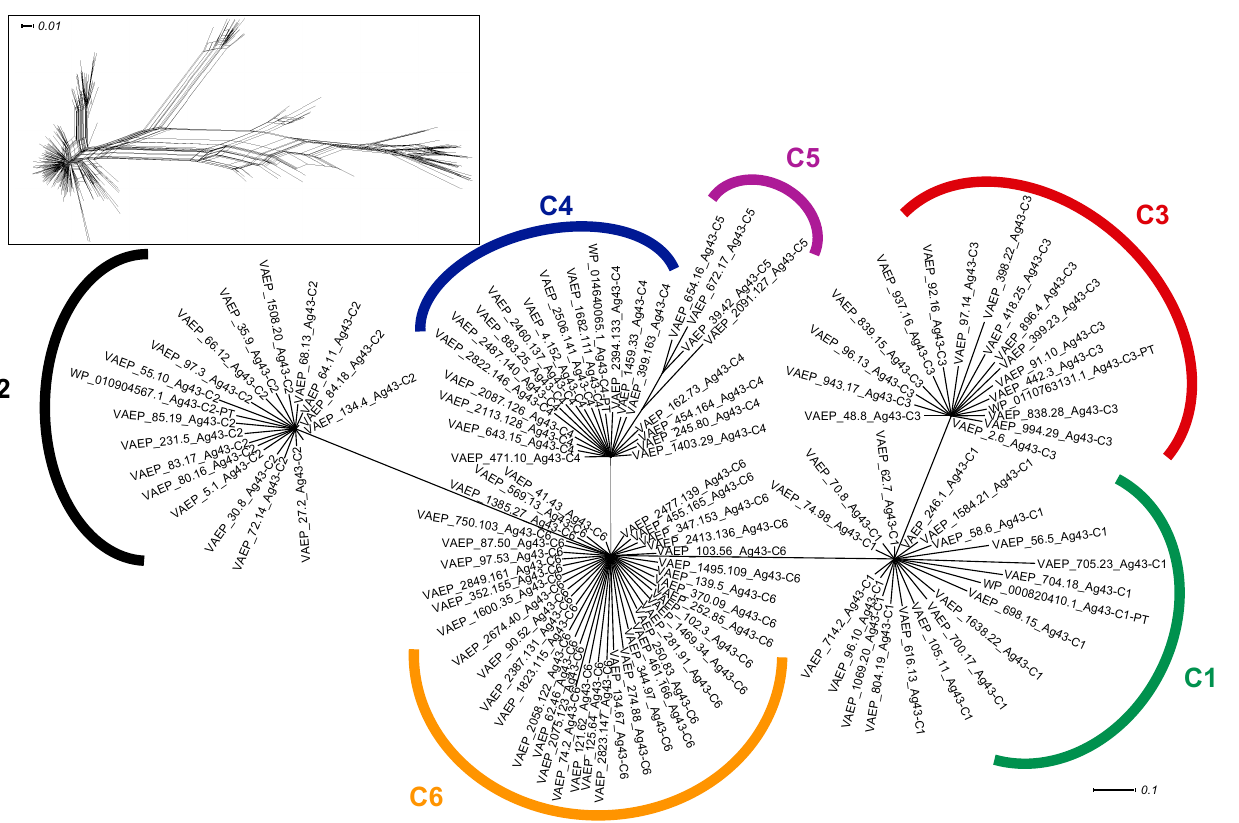
Figure 3. Phylogenetic analysis of the passenger domain of Ag43. Trees were generated using SplitsTree; the insert represents the trees before applying bootstrapping and confidence threshold. Ag43 groups into six different classes. For legibility, sequences that were identified but have not been included here are available in Table S1. Scale bars represent the evolutionary distance. As previously reported [29], there is often (but not always) a relationship between clustering and the size of Ag43 passengers, which ranges from between 500 amino acids for C1 and C3, and 430 amino acids for the four remaining classes (supplementary Table S1). While C1 to C4 harbour previously investigated Ag43 homologues, namely from E. coli K12 MG1655 (UPI00003B25EE), enterohaemorrhagic E. coli (EHEC) O157:H7 EDL933 (UPI00000D07E5), uropathogenic E. coli (UPEC) CFT073 (UPI00000E49D2), and enterotox- igenic E. coli (ETEC) O78:H11 H10407, respectively [29], no Ag43 homologues from C5 and C6 have been functionally or structurally characterised to date. Given the passenger domain is composed of three different subdomains [20,21,29], further phylogenetic network analyses were performed on each subdomain (Figure 4). While two robust clusters of SL sequences of type 1 and 2 were still unambiguously dif- ferentiated, it further appeared that SL1 and SL2 could be further divided into subtypes. SL1 split into clusters represented by subtypes a, b, and c, whereas SL2 could be differen- tiated into two subtypes, a and b (Figure 4A).